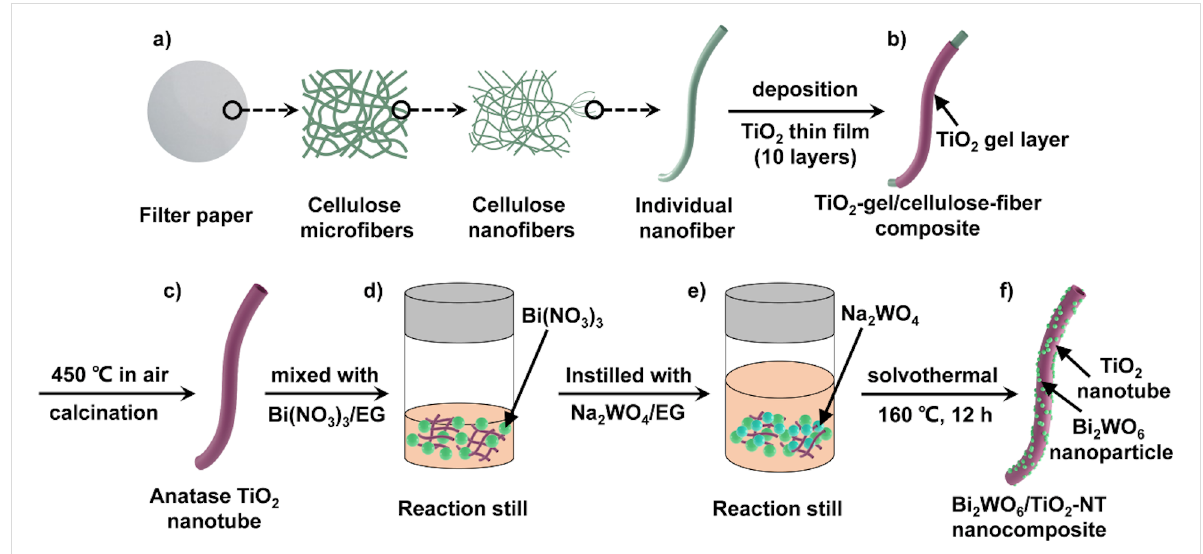
Figure 1: Schematic illustration of the fabrication process of cellulose-derived Bi 2 WO 6 /TiO 2 -NT nanocomposites.